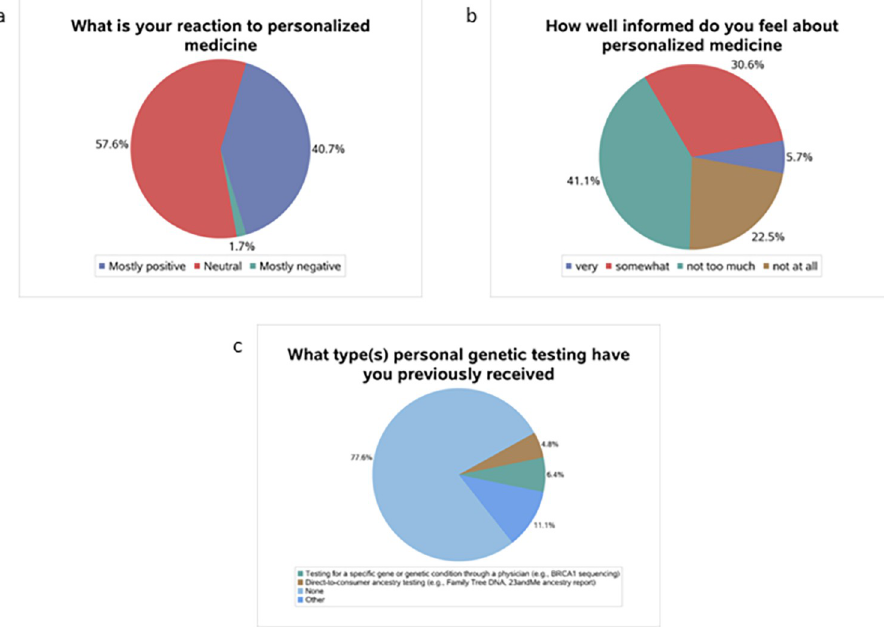
Fig 1. Respondent’s awareness of personalized medicine. ( a ) What is the reaction of participants to the personalized medicine; ( b ) how well informed did participants feel about personalized medicine among participants; ( c ) what type (s) of personal genetic testing have participants previously